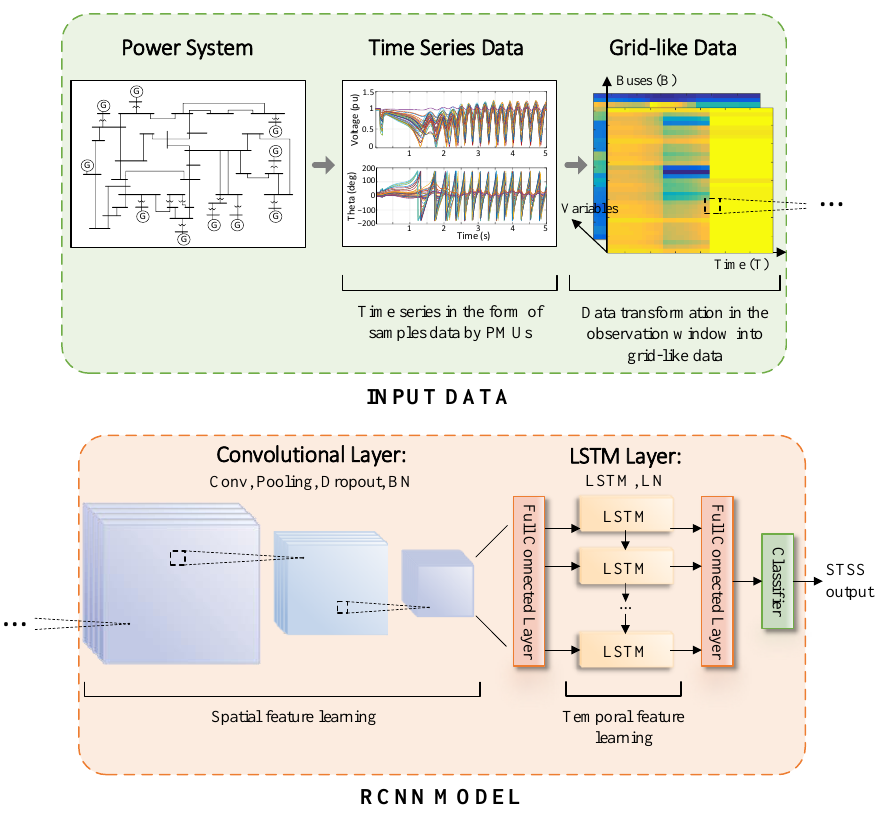
Figure 2. Overall framework of RCNN